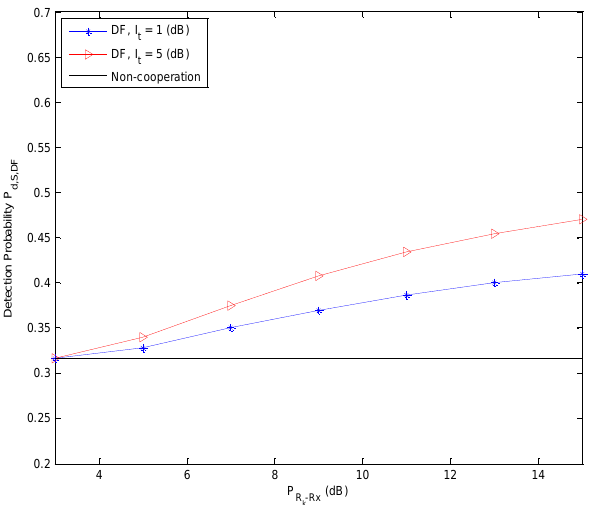
as a function of the received power d,S,DF in the DF-CSS scheme (P k